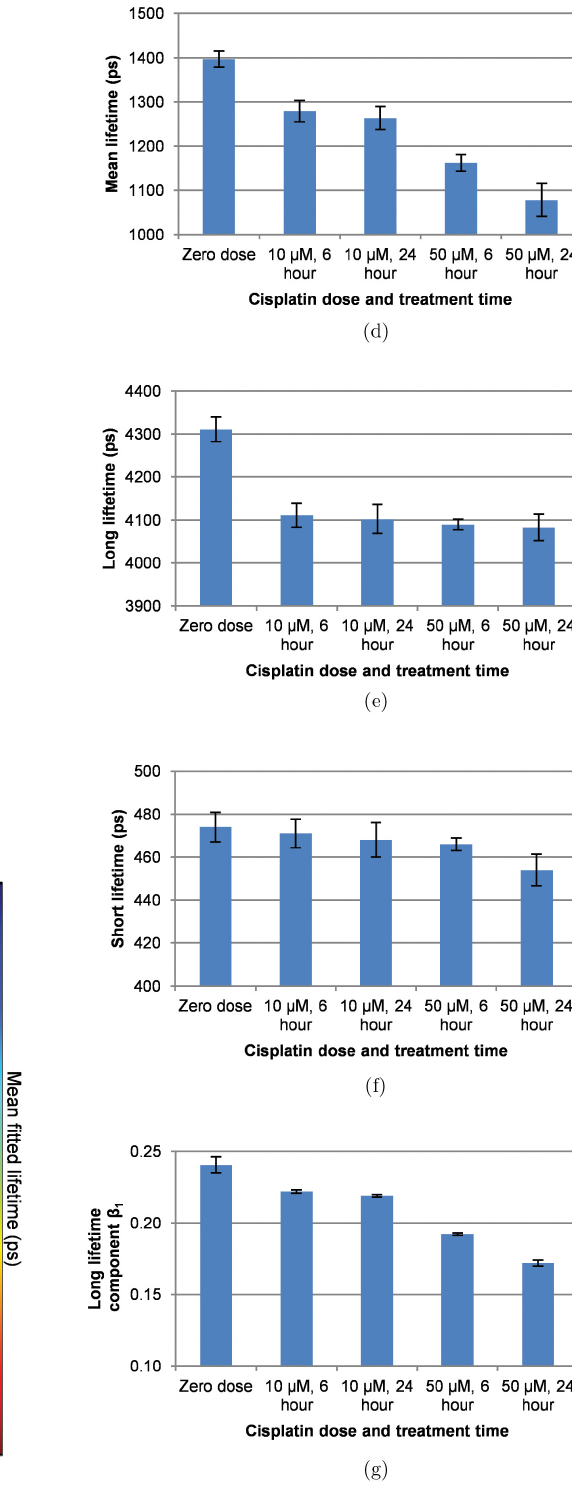
Fig. 6. Results showing e®ect of cisplatin treatment dose and time on MCF7 cells. (a) Plate map indicating cisplatin treatment dose and time. (b) False-color map showing mean ¯tted lifetimes obtained for each well across the plate. (c) Exemplar intensity merged FLIM images from the dataset with false color scale showing ¯tted mean lifetime ( scale bar ¼ 50 (cid:1) m). (d) – (g) Fitted parameters presented by condition with error bars representing standard errors over repeat wells.